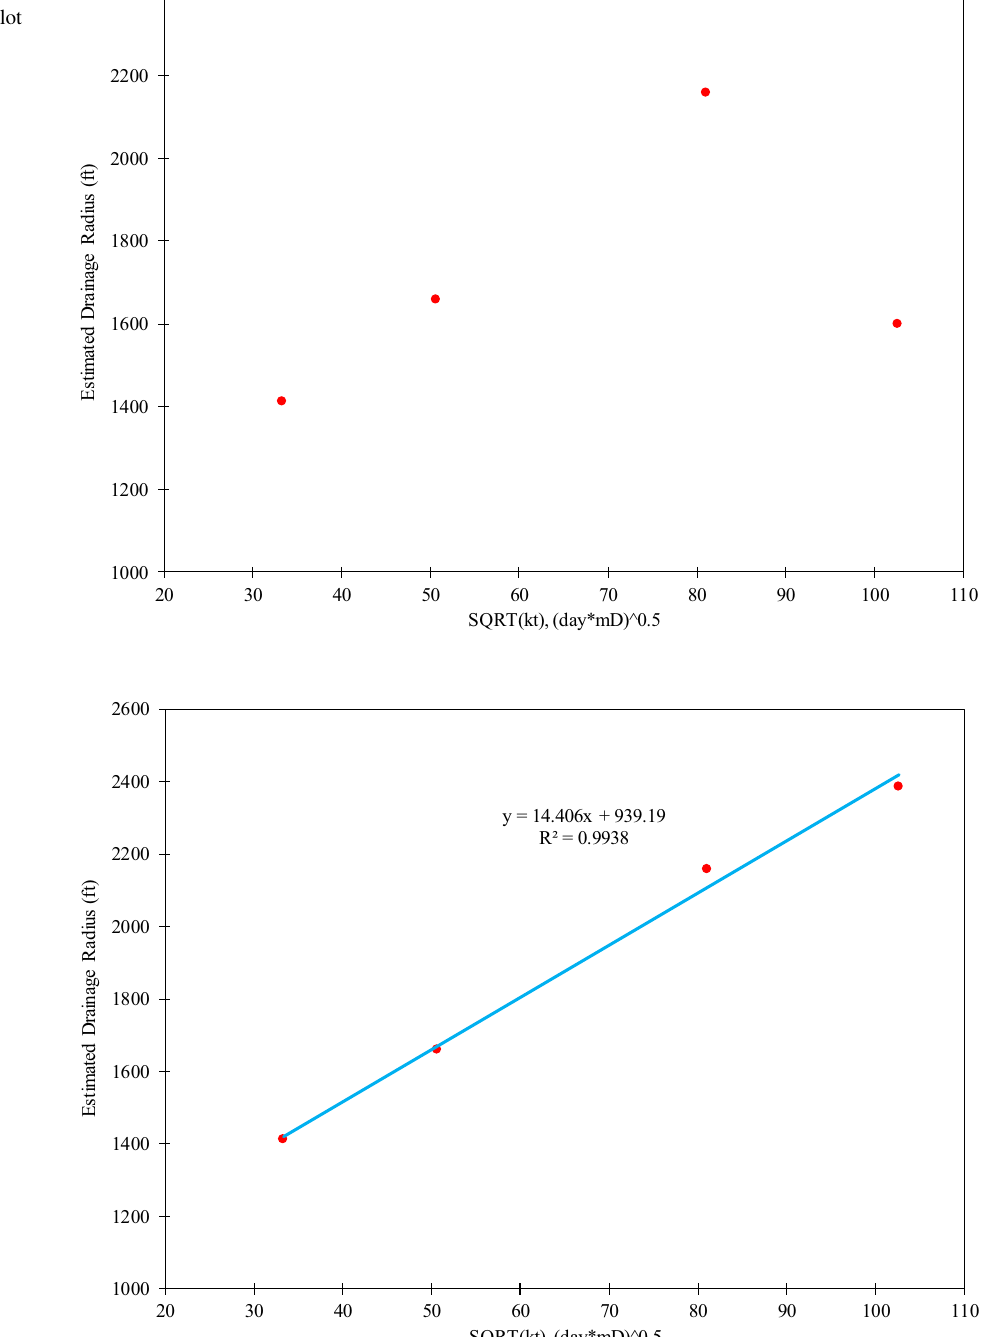
Fig. 9 a Plot of drainage radius versus (kt), no correction. b Plot of drainage radius versus (kt), corrected